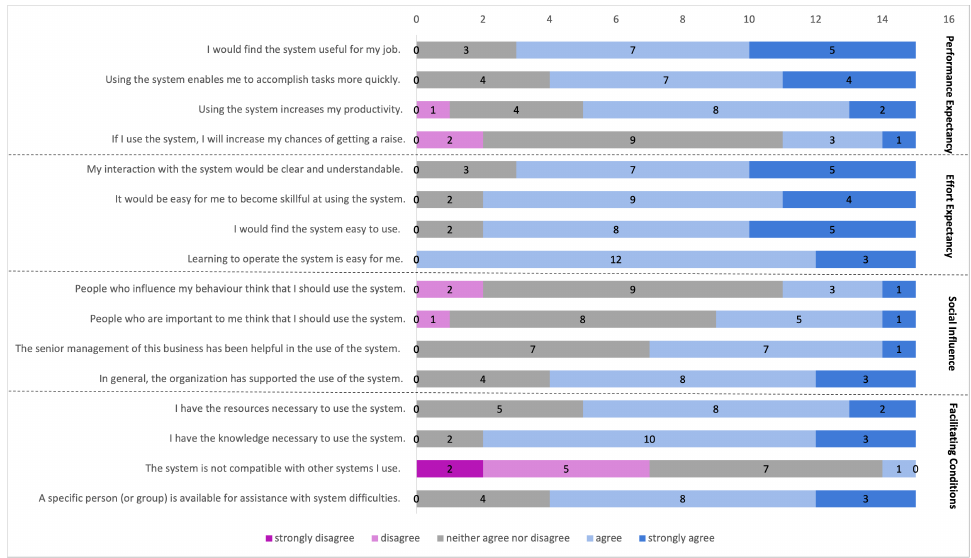
Figure 27. The UTAUT questionnaire result for the analysis of biological efficacy in by-products use case. Each coloured section indicates the number of participants who responded between ‘strongly disagree’ and ‘strongly agree’ (i.e.,